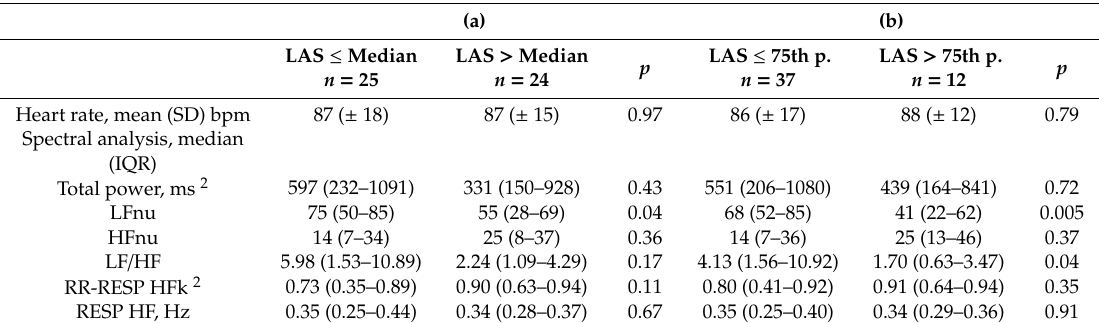
Table 3. Autonomic parameters evaluated by spectral analysis of patients on the waiting list for lung transplant stratified by Lung Allocation Score (LAS). Comparisons between patients with LAS ≤ and > than the median (a) and between patients with LAS ≤ and > than the 75th percentile (b) .